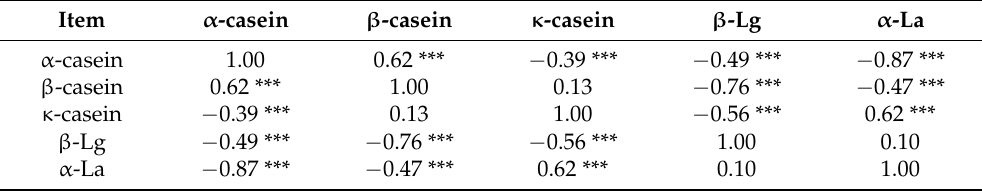
Figure 1. A representative Sodium Dodecyl Sulphate Polyacrylamide Gel Electrophoresis (SDS- PAGE) of caseins and whey proteins resulting from bovine milk samples obtained in four different seasons from two different farming systems. The trend of major protein fractions was evaluated and confirmed by Pearson correla- tion (Table 4). Table 3. Quantification of protein bands in milk samples in four seasons between two different Table 4. Pearson correlation coefficient between caseins fraction and whey proteins.